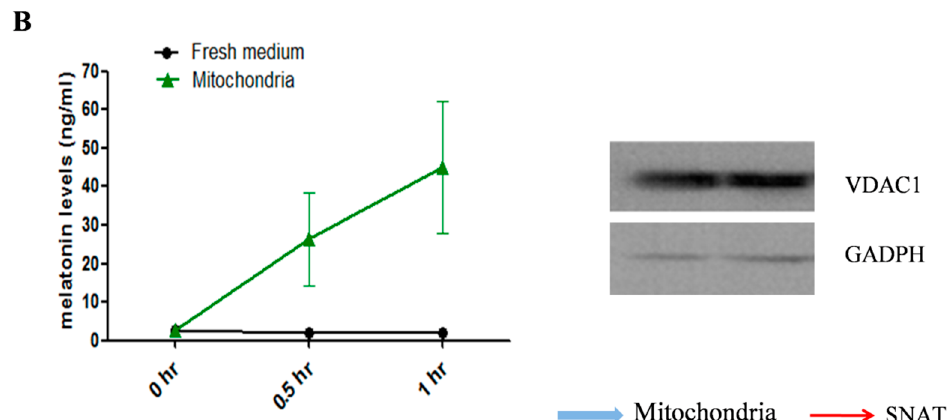
Figure 2. The localization of SNAT in oocyte and melatonin levels in mitochondria culture medium. ( A ) SNAT distribution sites. The red arrows point to SNAT enzyme (black dot), the blue arrows point to the mitochondria with SNAT localized in; ( B ) Melatonin concentrations in culture medium during mitochondria culture (mean ± SEM).